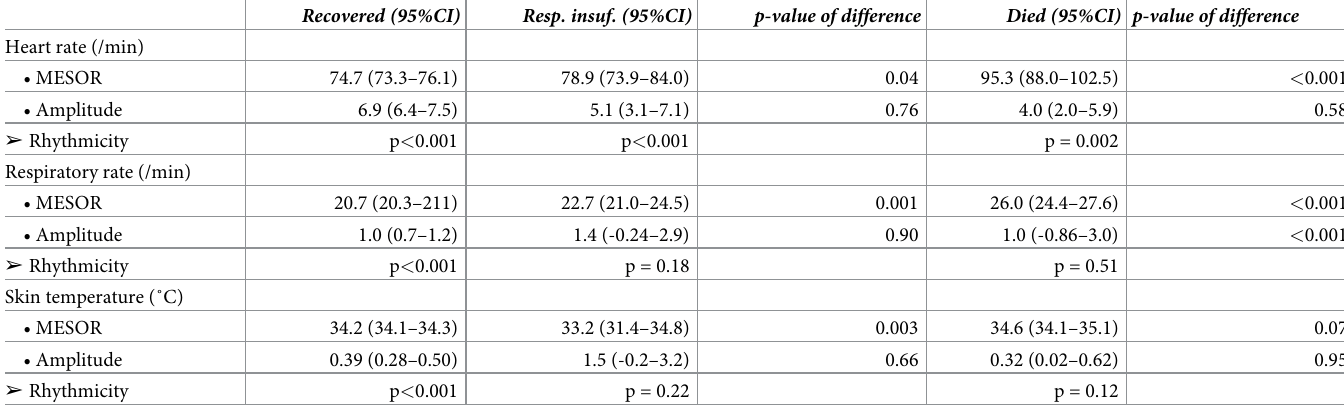
Table 2. Coefficients of cosinor models. Recovered patients are compared to patients with respiratory insufficiency and deceased